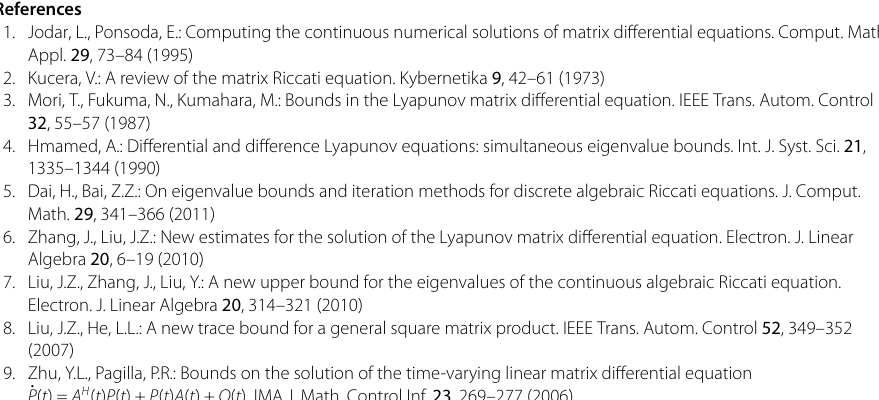
We depict the plot (see Fig. 1) based on all these results. In the plot, the dashed line presents the result of (45). The dot line denotes the result of (46). The real line shows the result of (47). From the plot we can get the bounds of the solution of